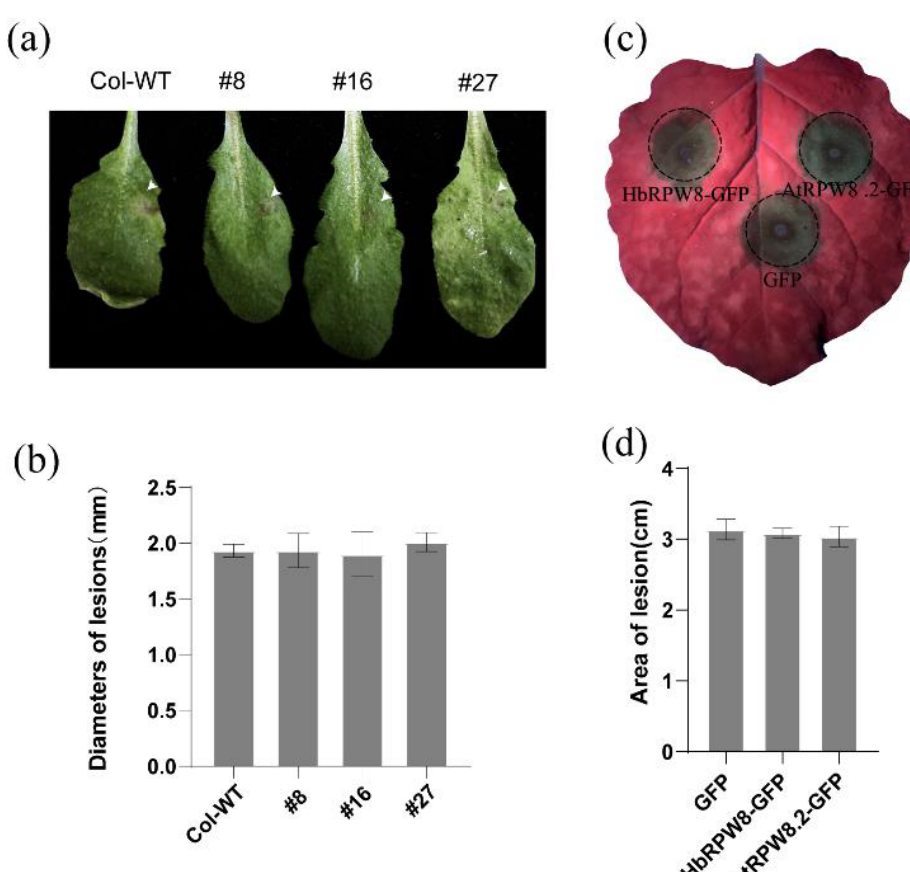
Figure 7. The responses of HbRPW8-a over-expressing lines and Col-WT to P. capsici or B. cinerea inoculation. ( a ) Macroscopic evaluation of symptoms 3 dpi with B. cinerea inoculation of Col-WT and transgenic lines; necrotic area was highlighted by the arrow; ( b ) and ( d ) measurement of lesion size at 3 dpi; Data were shown as the means ± SD from three independent experiments and no significant difference ( p < 0.05). ( c ) macroscopic evaluation of symptoms at 3 dpi with P. capsici inoculation of tobacco leaf expressed with GFP, HbRPW8-a-GFP or